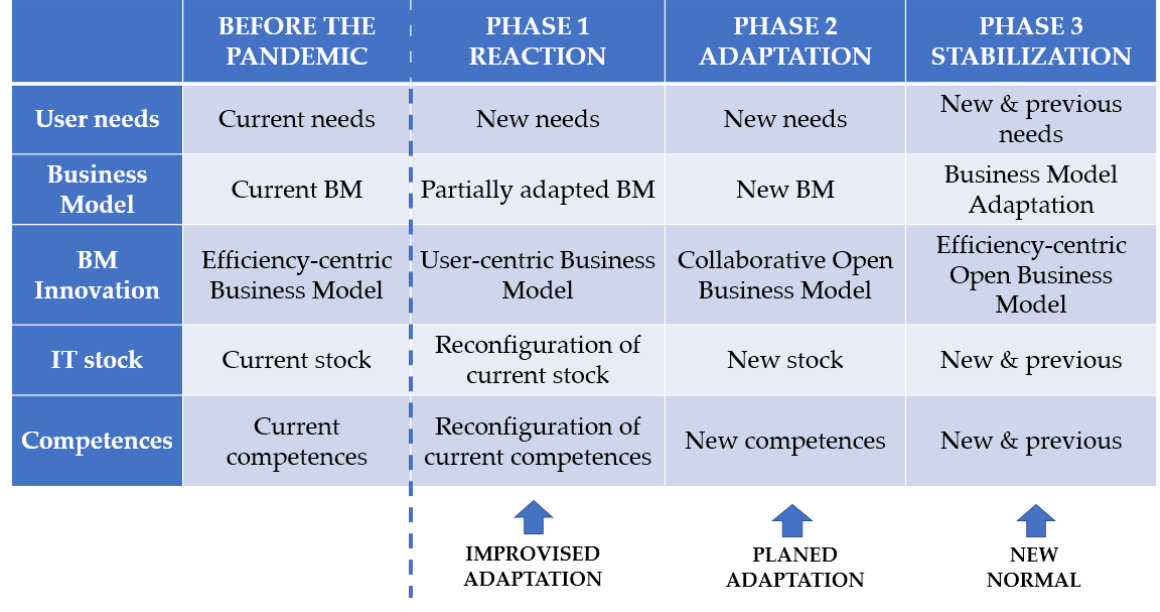
Figure 1. The three phases of business model adaptation in the cultural and creative industry.